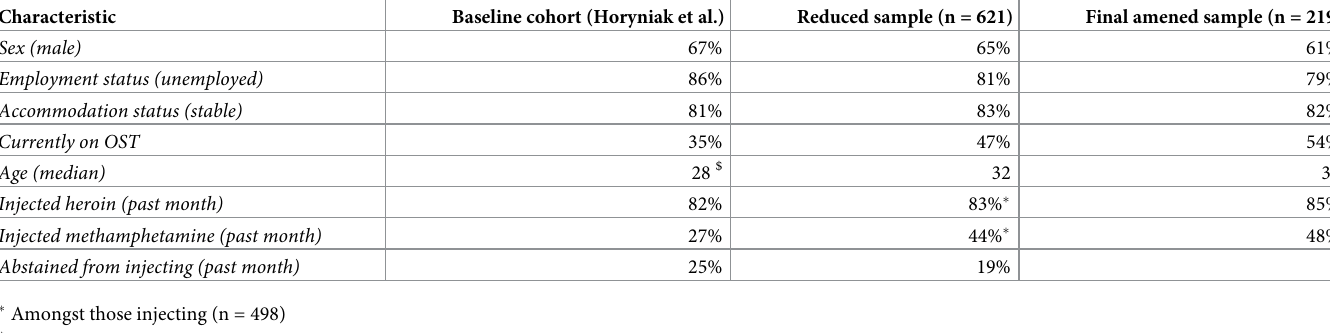
Table 1. Demographic and drug use differences between MIX cohort samples in Melbourne, Australia